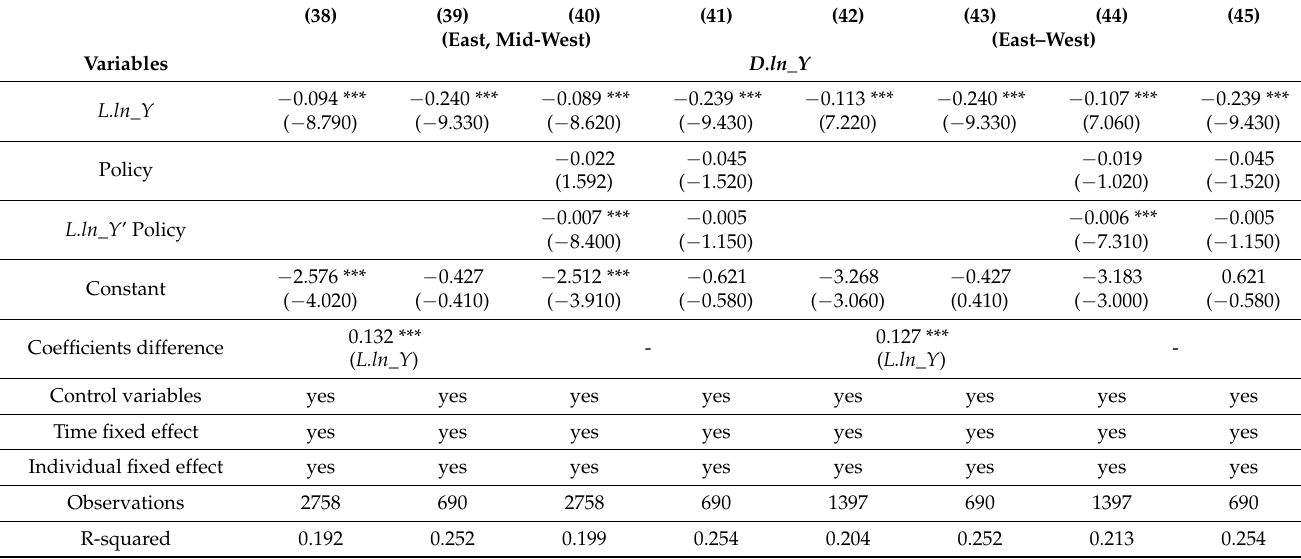
Table 8. Regional heterogeneity test (Convergence